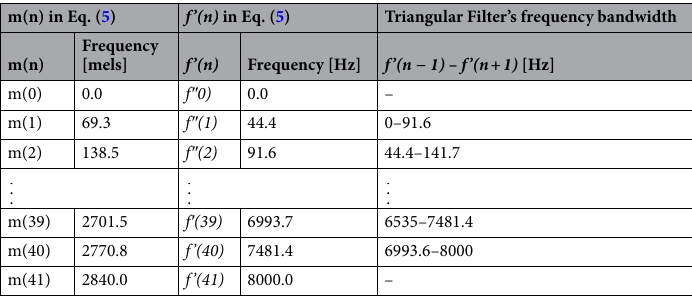
Table 4. Mel-scale conversion chart.